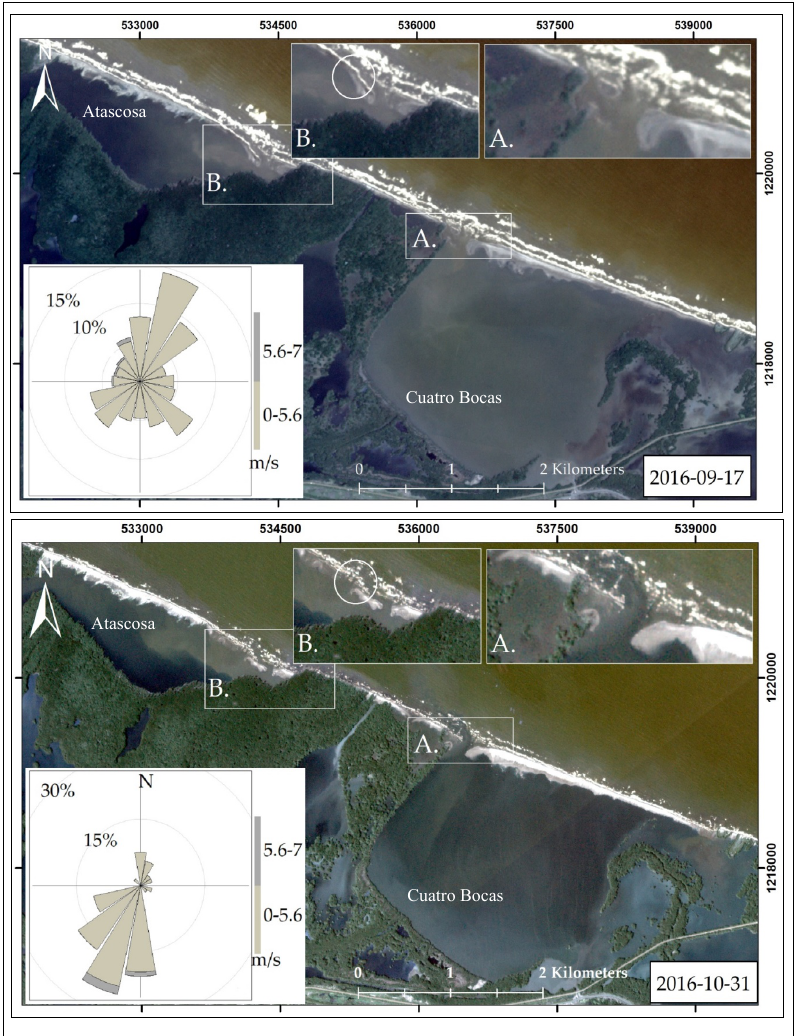
Figure 10. Breaching process for the La Atascosa lagoon in October 2016. Top: the image was taken on September 17, 2016, showing prior breaches but an intact barrier otherwise. Bottom: image shows that a second breach was formed (circled area) in the Atascosa lagoon. Wind roses indicate wind conditions two weeks prior to image acquisition. Rapideye imagery courtesy of Planet Labs.